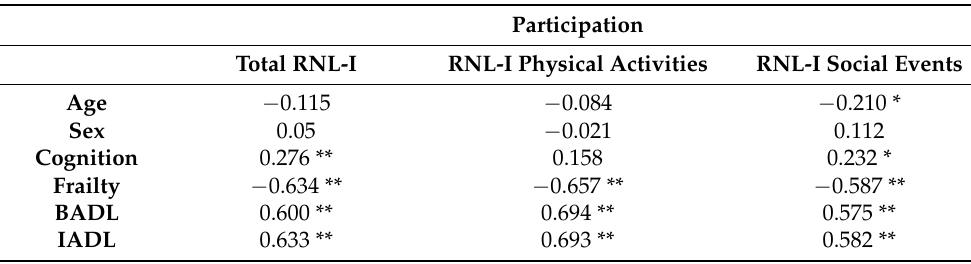
Table 3. Correlation matrix between participation and the demographic, frailty, cognition, and ADL variables (N = 121).